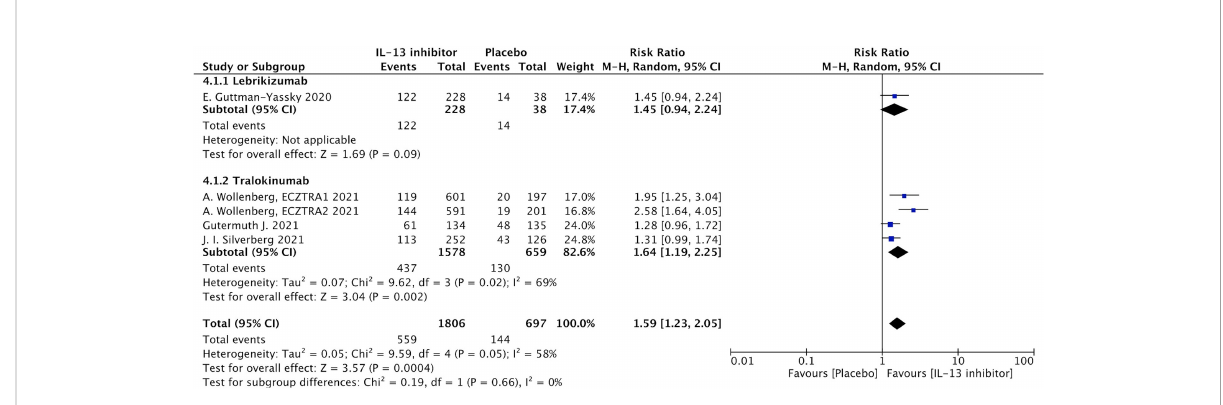
FIGURE 3 Forest plot for the proportion of patients achieving NRS score with more than 4-points daily improvement at the end of antagonizing IL-13